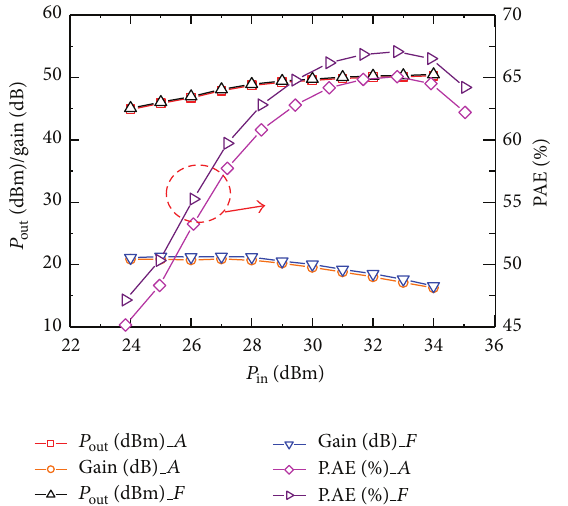
Figure 6: Output power, gain, and PAE versus input power for the 100-Watt 𝐹 + 𝐴 product.